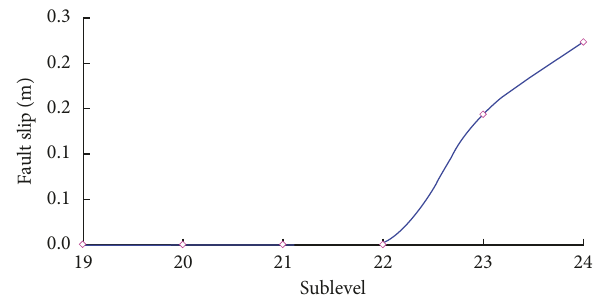
Figure 21: Relationship of the slip amount of fault FC3 with mining depth.